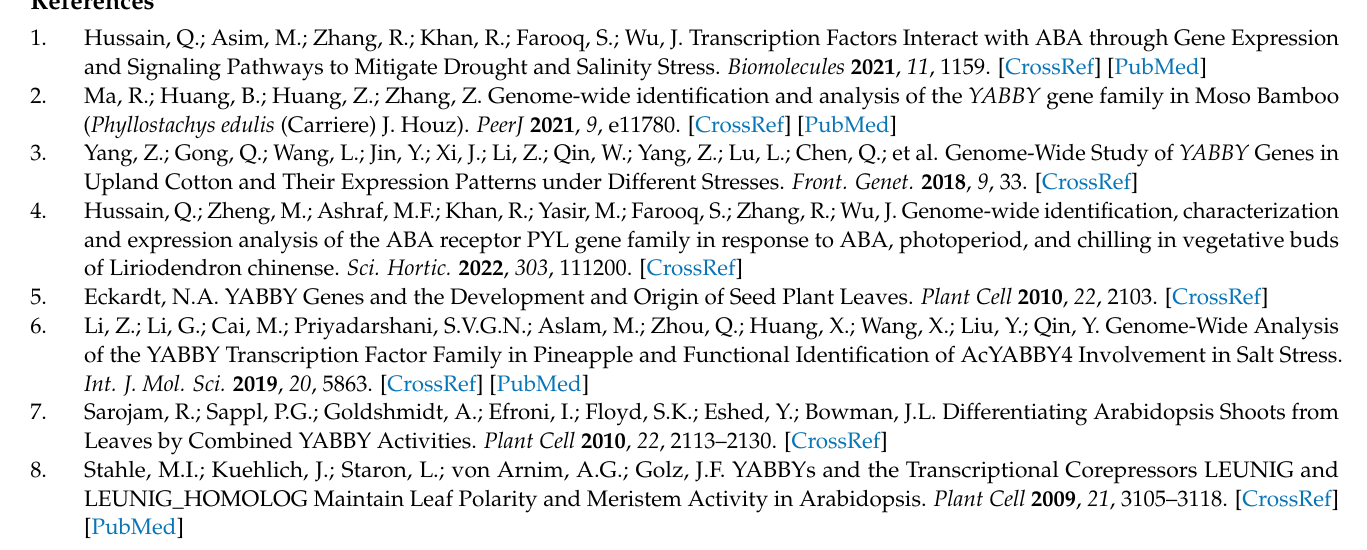
alignments of StYAB gnese; Figure S2: Heat Map representing sub-cellular localization of all seven StYAB genes; Figure S3: YABBY genes distribution chart representing, total number of YABBY genes from different species in 5 sub-groups based on phylogenetic analysis; Figure S4: Distribution of StYAB genes on potato chromosomes, lines predicting the possible gene duplication on different chromosomes; Figure S5: Fold Enrichment chart representing the overlapping StYAB genes functions; Figure S6: Heat map shows the expression profile of the StYAB genes in leaves and Roots of potato cultivar under different levels of Cadmium stress i.e., Control = 0 mg per kg, T1 = 1 mg per kg and T2 = 5 mg per kg); Figure S7: Heat map shows the expression profile of the StYAB genes in Dormant and Non- Dormant potato cultivar; Figure S8: Heat map shows the expression profile of the StYAB genes in leaves of four different potato cultivars under drought stress; Figure S9: Heat map shows the expression profile of the StYAB genes in petiole of potato cultivars under different photoperiod; Figure S10: Heat map shows the expression profile of the StYAB genes in phloem associated cells of petiole and lower stem of potato cultivar; Figure S11: Heat map shows the expression profile of the StYAB genes in tubers of two potato cultivars (Phytophthora Infestans resistant and susceptible) after different time of inoculating infection in both cultivars (0 h, 24 h, and 48 h); Table S1: Putative Cis- regulatory elements found in promoter regions of StYAB genes; Table S2: StYAB genes distribution among groups based on phylogenetic analysis; Table S3: Ka/Ks ratio duplicated gene pairs in potato; Table S4: miRNA targets prediction of StYAB genes. The miRNA data was downloaded from psRNATarget (Online Web